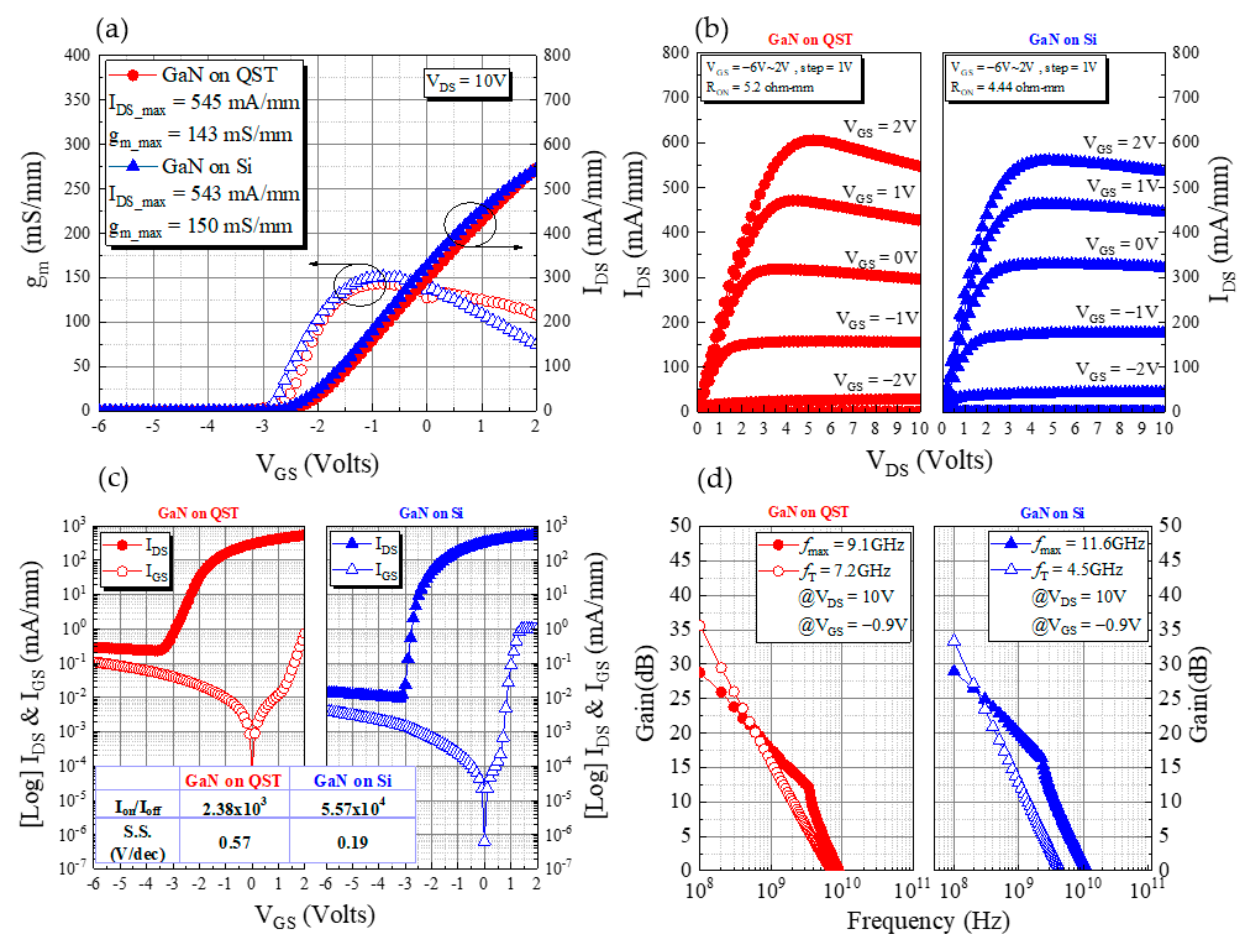
Figure 3. ( a ) Transfer characteristics ( I DS – V GS ) at V DS = 10 V with a V GS sweep of − 6 to 2 V, ( b ) I DS – V DS output current at a V GS sweep of − 6 to 2 V with a step of 1 V, ( c ) off-state leakage current curves of the drain (log-scale I DS – V GS ) and gate ( I GS – V GS ), and ( d ) small-signal characteristics of the QST and Si devices.